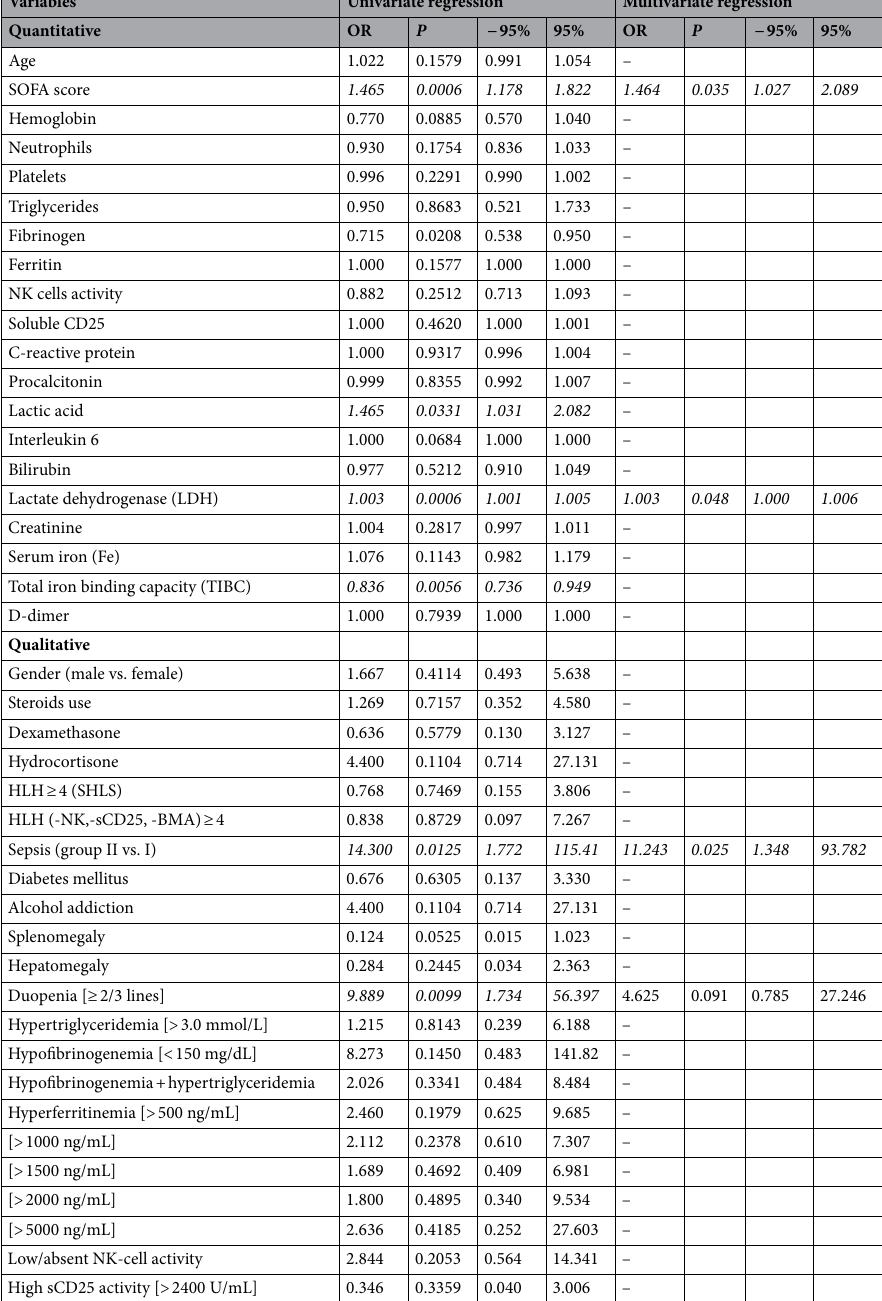
Table 5. Variables associated with the death of the patients (n = 104. Univariate logistic regression and multivariate stepwise regression – for quantitative variables with p < 0.05 for the model; for qualitative with p < 0.2 for the model). The level of statistical significance was determined with the value of ( p < 0.05). OR, odds ratio; 95Cl, 95% Confidence interval; sCD25, Soluble CD25; HLH (-NK,-sCD25, -BMA) ≥ 4, met 4 out of the 5 HLH criteria in the sepsis patients (without NK cells activity, sCD25 concentration and bone marrow